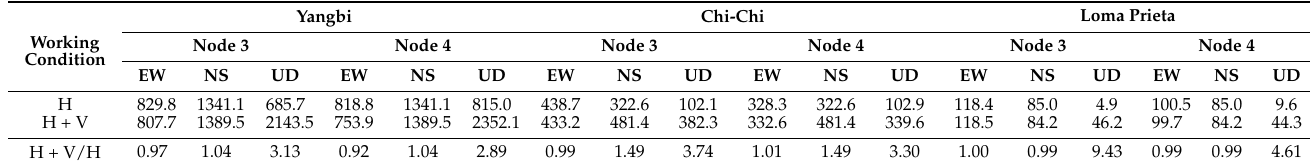
Table 8. Peak acceleration of the top layer in EW, NS, and UD directions/(cm · s − 2